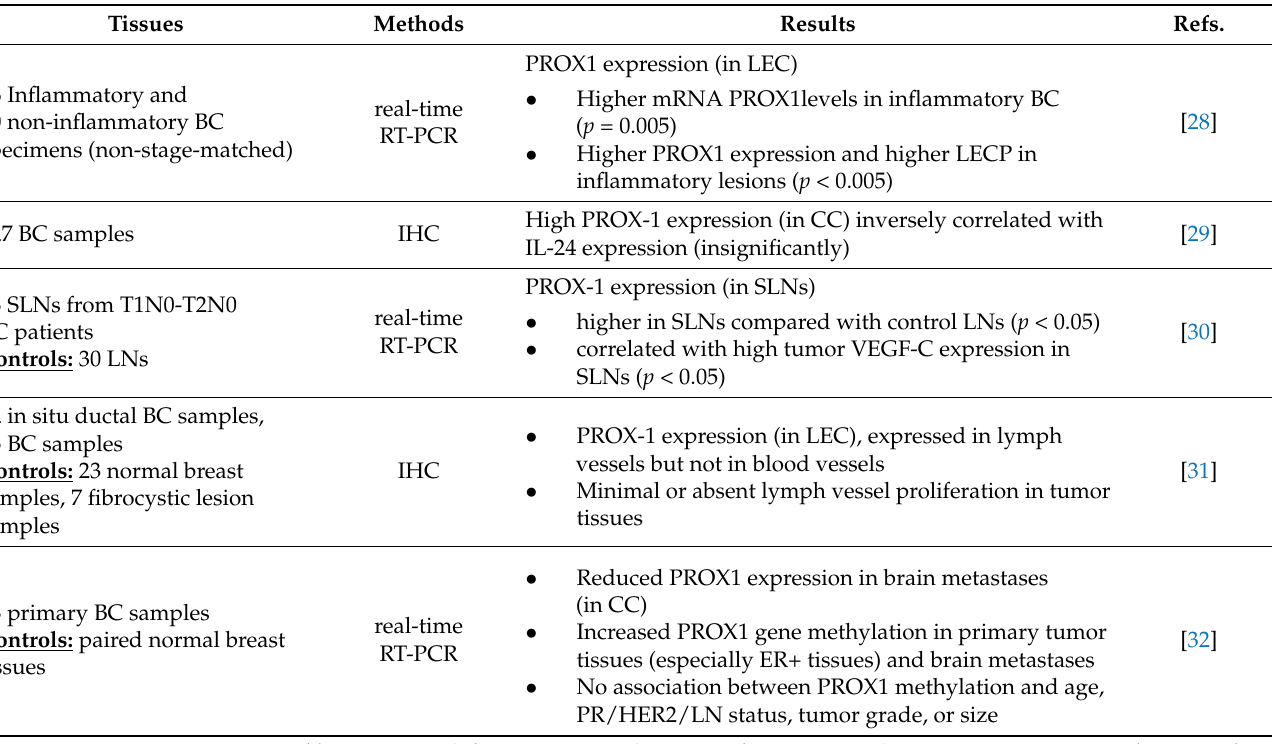
Table 2. Synopsis of studies evaluating the expression and role of PROX-1 in breast